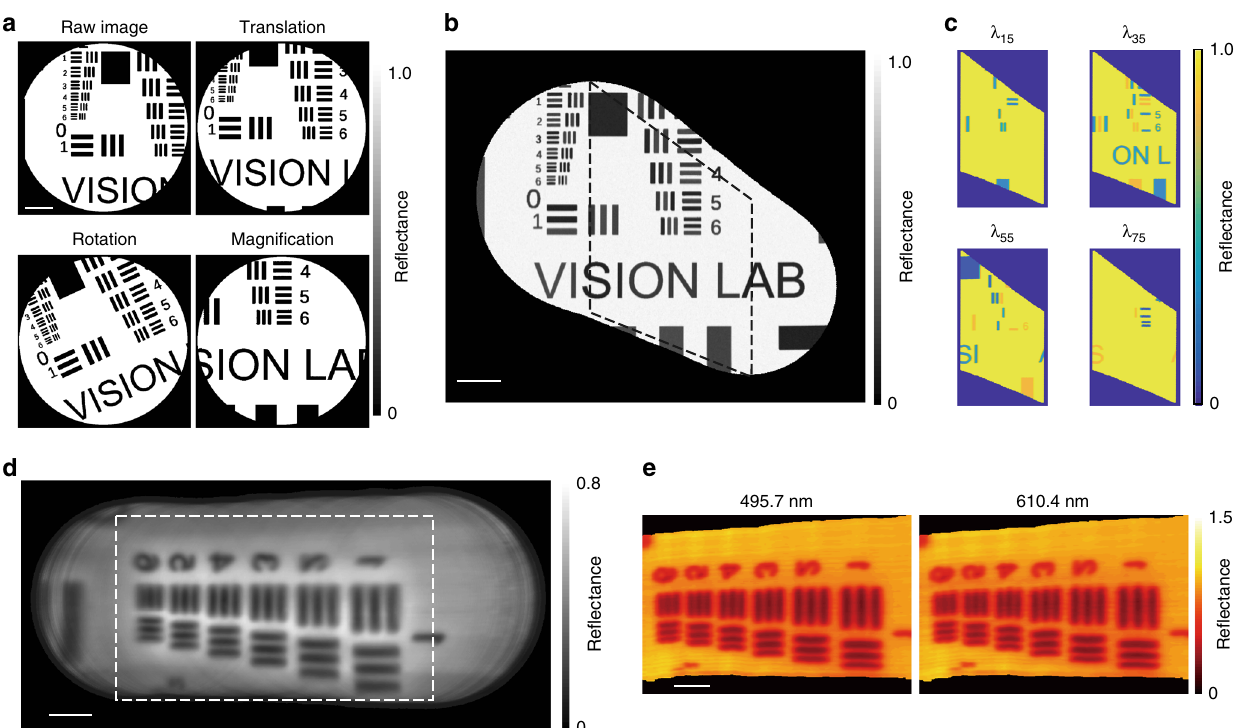
Fig. 3 Hyperspectral endoscopic line-scan slices can be co-registered using wide- fi eld reference images. a The three main types of image deformation were fi rst emulated in simulation. Three types of image deformation were applied during an endoscopic procedure, in which the image x axis was scanned. b Seventy-four wide- fi eld images were successfully co-registered and a combined image produced. c The geometric transformation matrix obtained from the wide- fi eld image registration procedure was then applied to the simulated spectral image data. Images are shown from four different simulated wavelengths. d Combined image from 360 experimentally measured and co-registered wide- fi eld images of a USAF 1951 resolution target. e Images from the experimentally reconstructed hypercube at two different wavelengths: 495.7 and 610.4 nm. Images acquired using the external illumination method. Scale bar in simulation a – c = 100 pixels. Scale bar in experimental data d , e = 1 mm. Dashed squares in b and d indicate the slit scanning areas